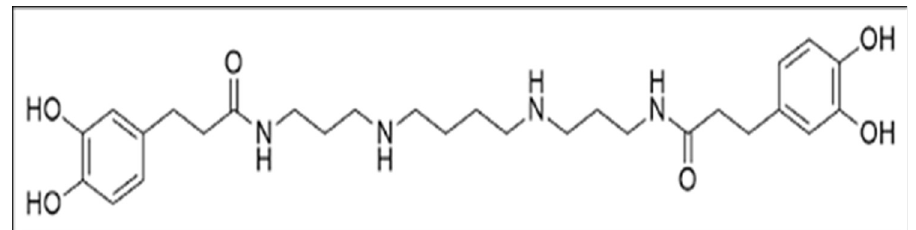
Fig 1. Chemical structure of kukoamine A (C28H42N406 https://pubchem.ncbi.nlm.nih.gov/).